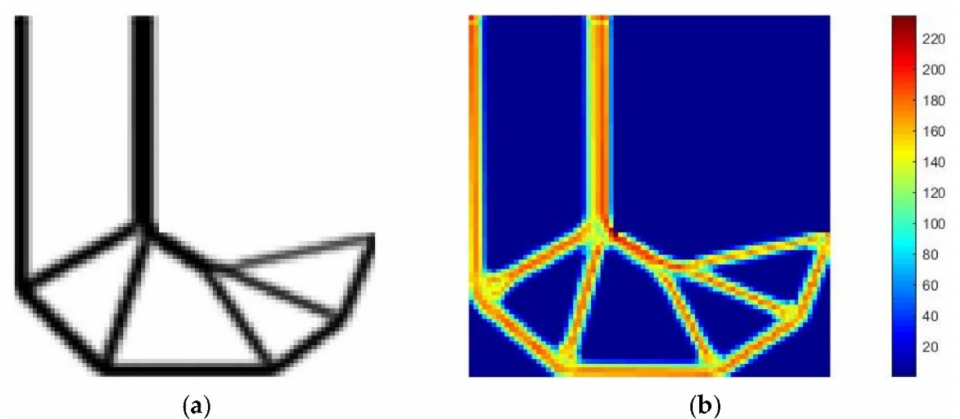
Figure 9. Deterministic topology optimization result of L-beam structure (6400 elements): ( a ) Topo- logical structure; ( b ) Von Mises stress distribution.